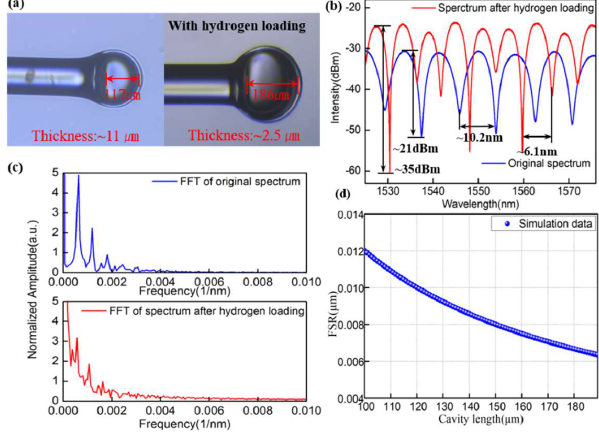
Figure 2. Without hydrogen loading and after hydrogen loading: ( a ) photographs of microfiber cavity, ( b ) spectrograms, ( c ) spatial frequency and ( d ) theoretical calculation on FSR as function of cavity length.